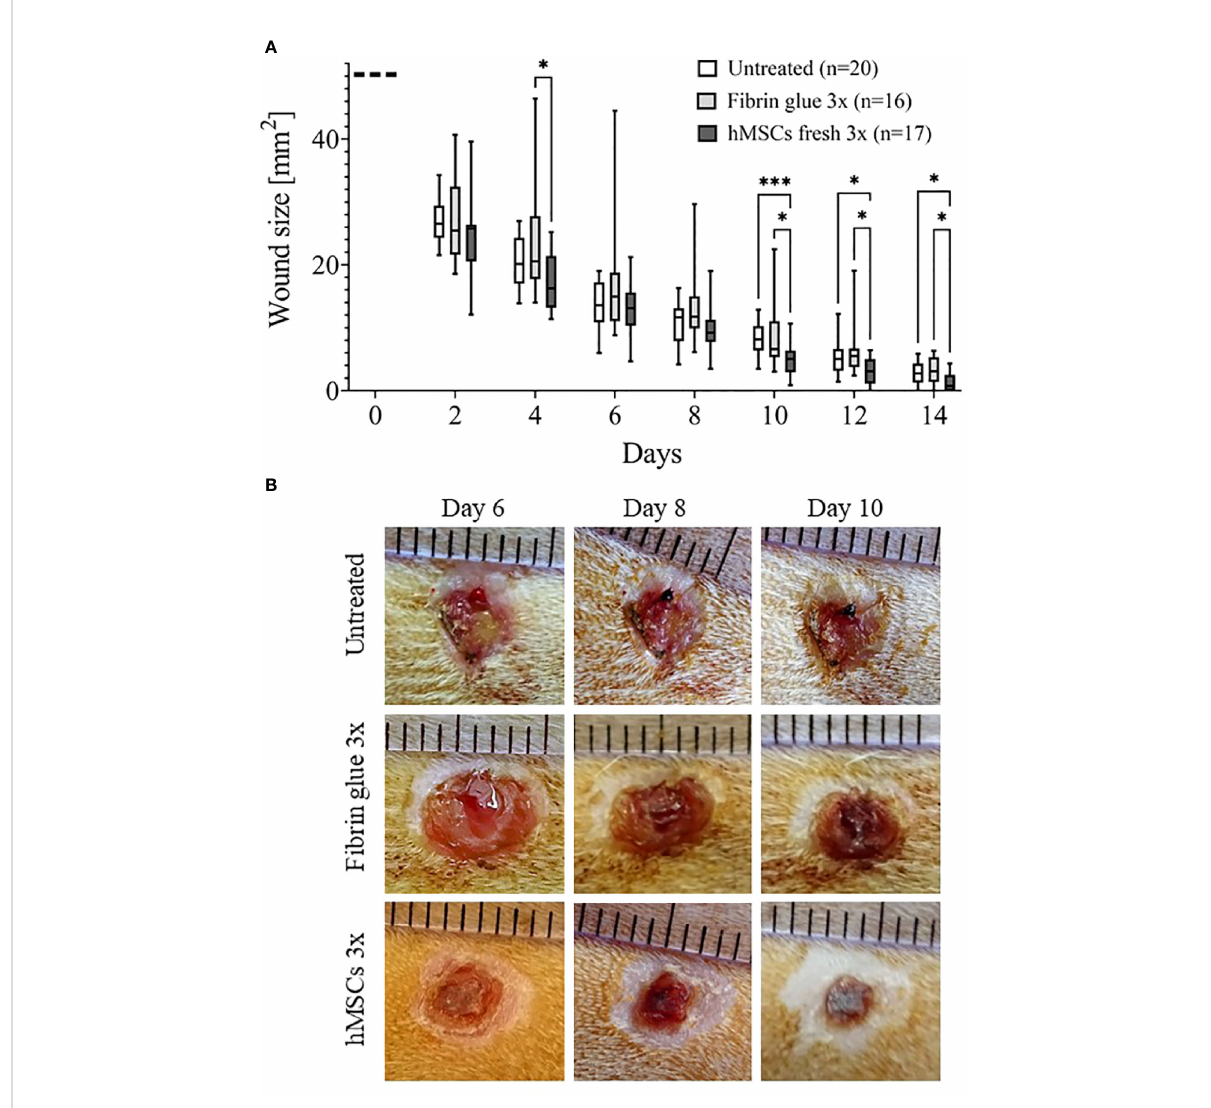
FIGURE 5 hMSCs improve wound healing. (A) Wound size reduction after 3-times repeated topical treatment with either hMSCs (1x10 6 /cm 2 ) in fi brin glue, cell-free fi brin glue or untreated at d0, d4 and d8 after wounding. Quanti fi cation of wound areas relative to initial wound area was performed with Image J. * p ≤ 0.05, *** p ≤ 0.001, as calculated using two-way ANOVA and Tukey multiple comparisons. (B) Representative images of wounded skin after 3-times repeated topical treatment with either hMSCs in fi brin glue, cell-free fi brin glue or untreated depicting crust formation, especially in fi brin glue-treated